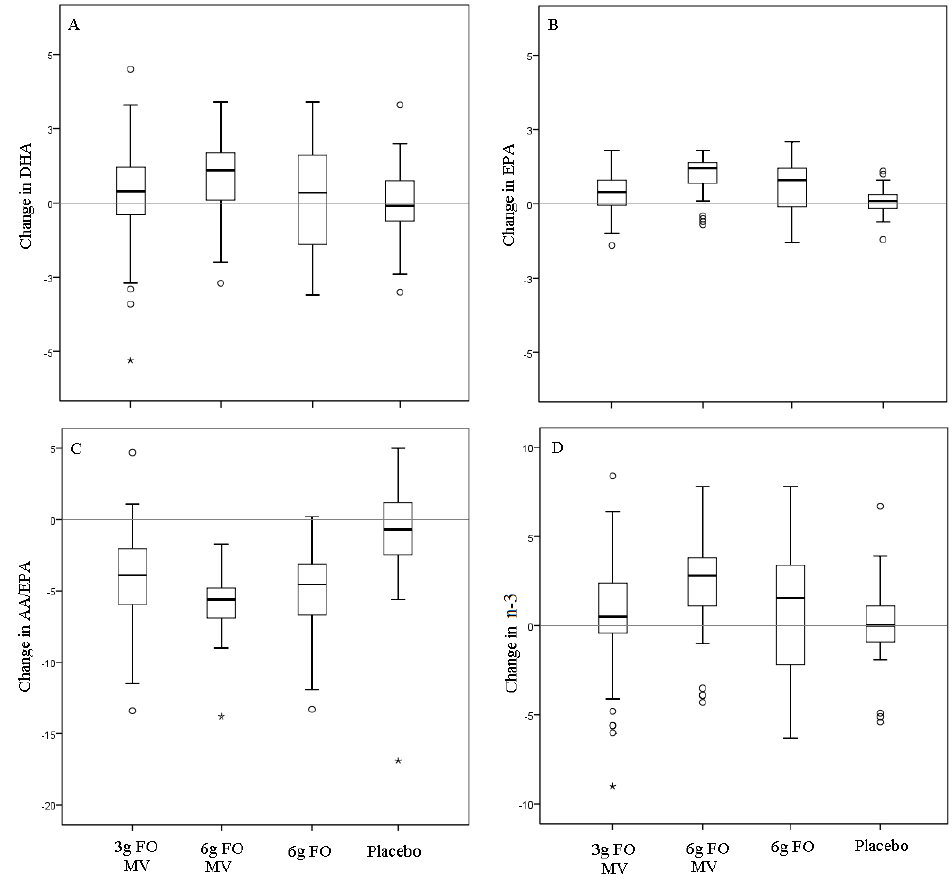
Figure 2. Variability in red blood cell incorporation stratified by treatment allocation for measures of DHA ( A ), EPA ( B ), AA/EPA ratio ( C ) and total n -3 fatty acid ( D ). EP: eicosapentaenoic acid, DHA: docosahexaenoic acid, AA: Arachidonic acid, FO: fish oil, MV: multivitamin. Circles and stars represent outliers less than 2 and greater than 2 standard deviations from the mean